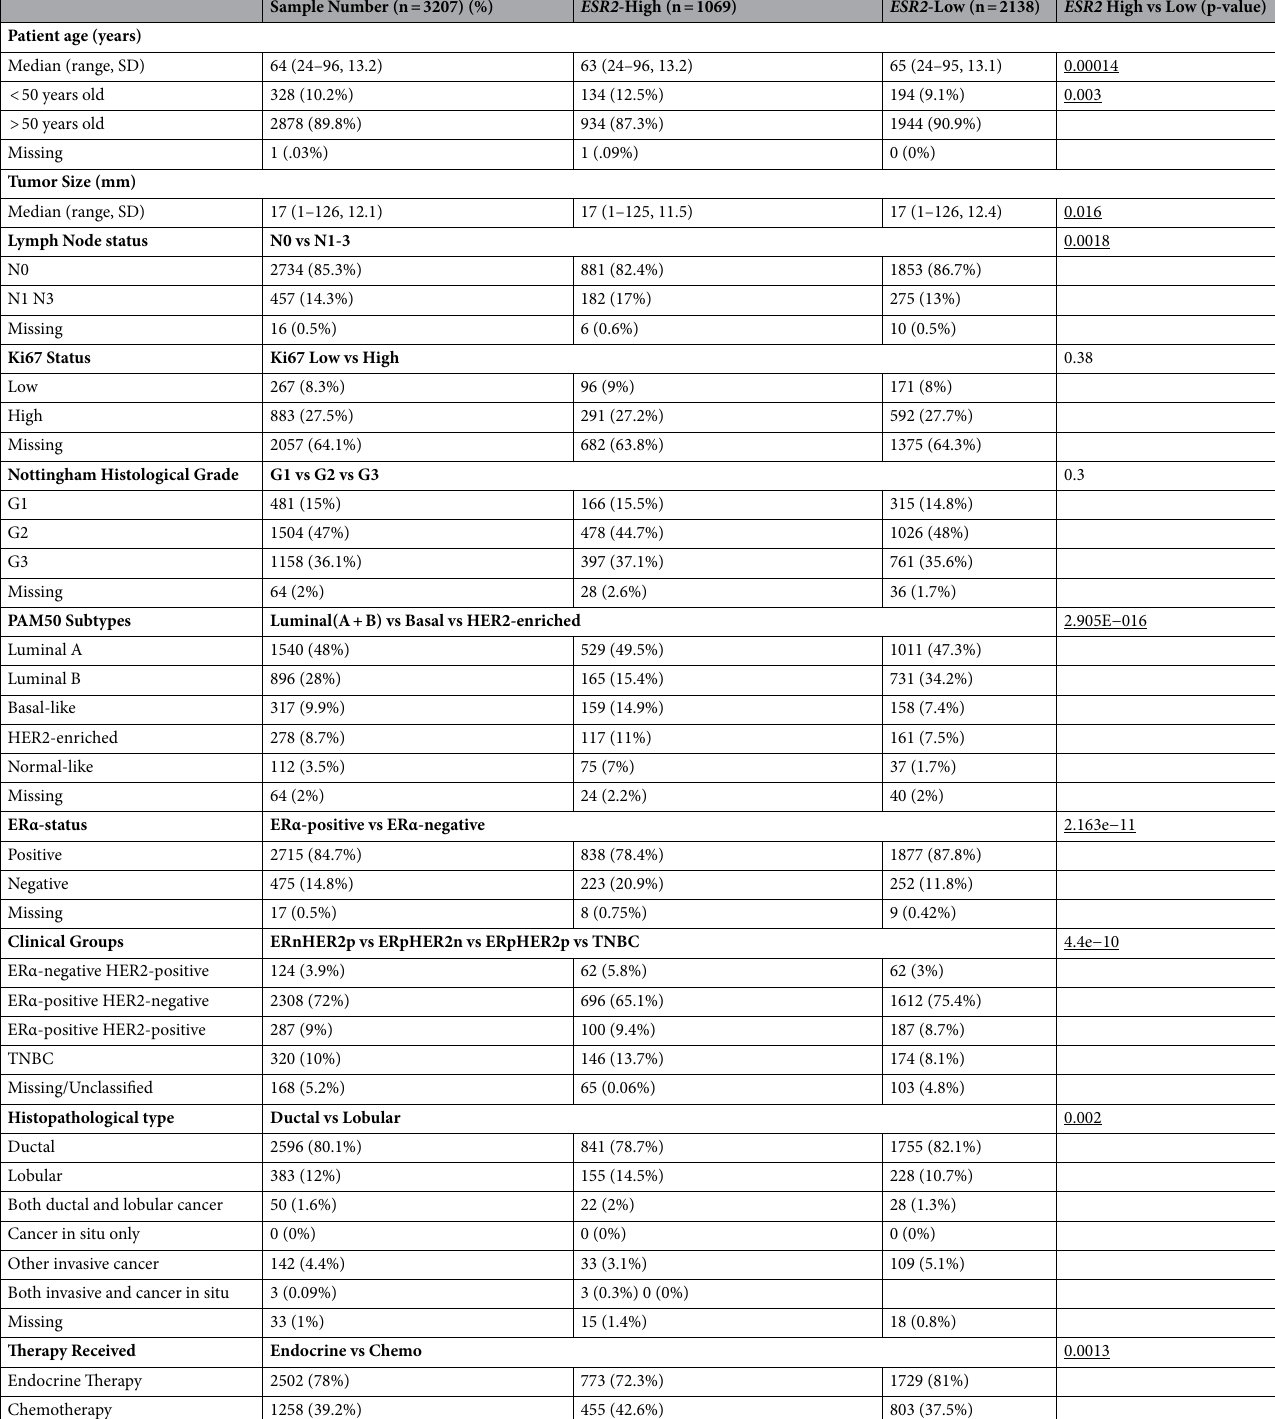
Table 1. Clinicopathological parameters of the SCAN-B cohort. Clinicopathological information was retrieved from the Swedish National Quality Register for breast cancer via SCAN-B. Variables are defined as in the standard Swedish clinical routine, with Ki67 status determined using local cut-offs. PAM50 subtyping is derived from the RNA-sequencing data as described in Brueffer et al. 46,47 . Significant p-values are